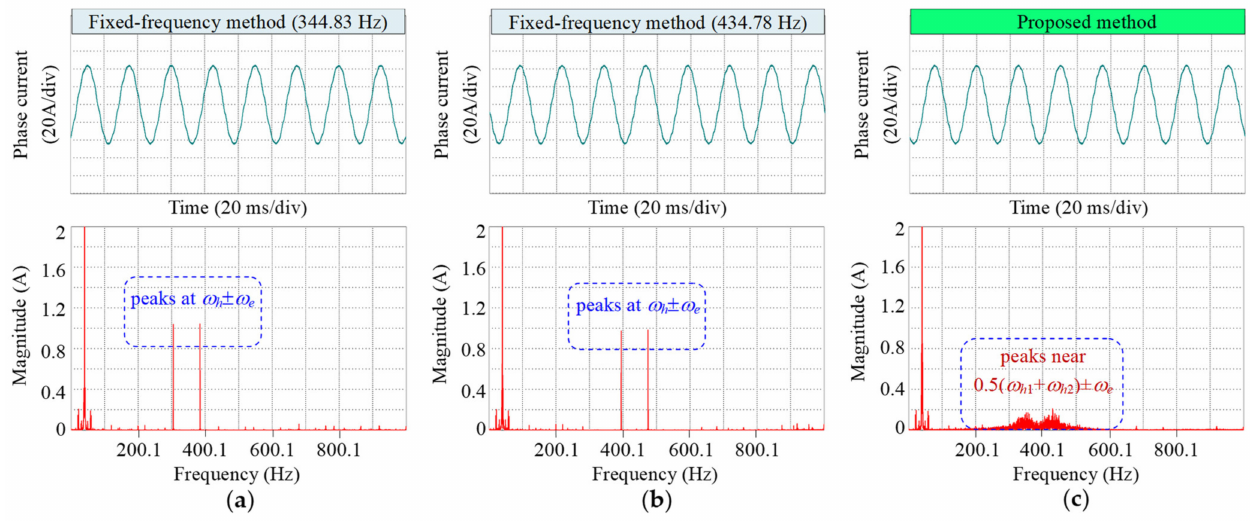
Figure 11. Stator phase currents and their FFT results of two different methods at 600 r/min under 40 N · m: ( a ) fixed-frequency method (344.83 Hz); ( b ) fixed-frequency method (434.78 Hz); ( c ) proposed PRFS